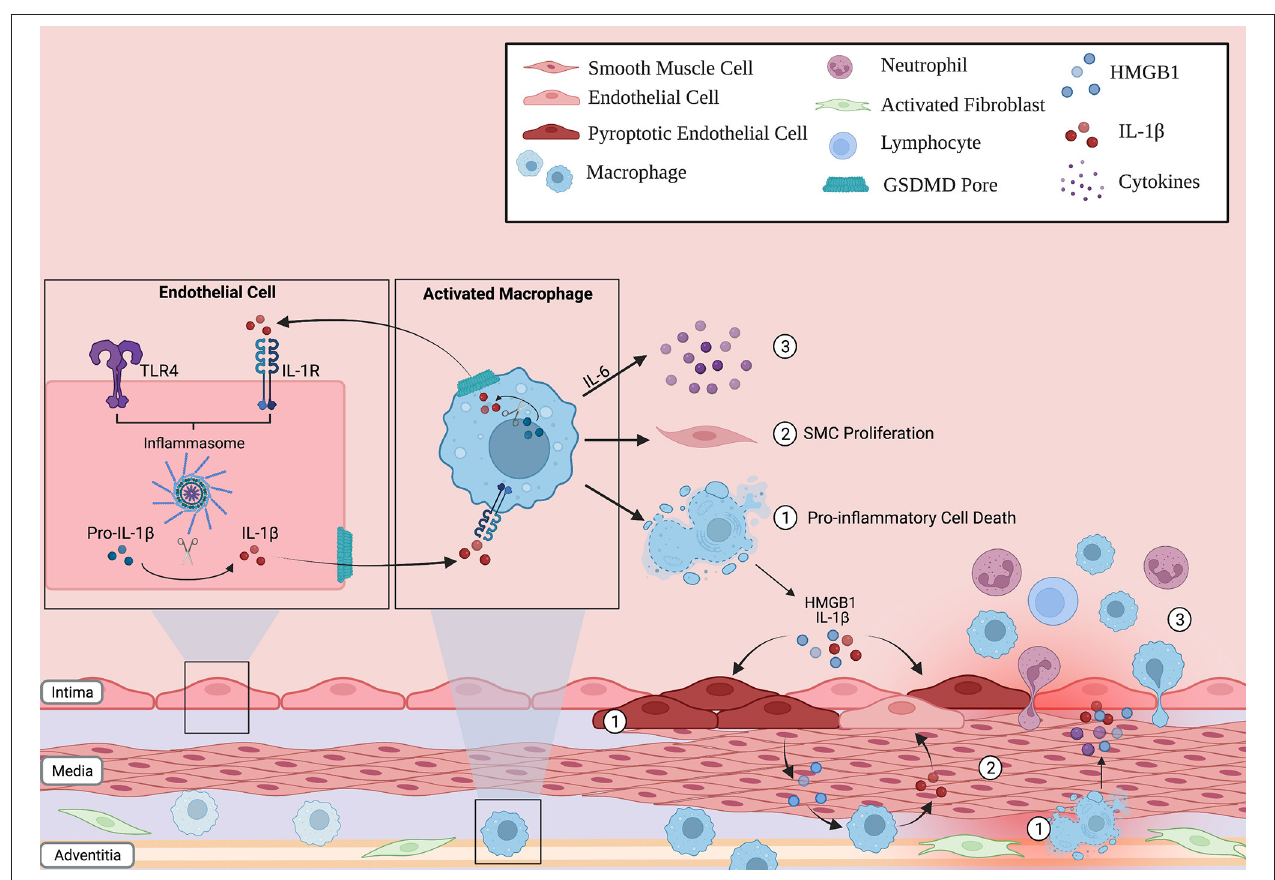
FIGURE 2 | Inflammasome action in the lung vascular environment. Immune cells (such as macrophages) and non-immune cells (endothelial cells) can respond to stress, activate the inflammasome pathway and undergo pyroptosis. The release of pro-inflammatory cytokines through the GSDMD pore, such as IL-1B, can propagate inflammation in neighboring cells by inducing their own transcription in a paracrine fashion. As such, the innate immune response can be amplified through the lung vasculature. In addition, these activated cells can (1) release other potent signaling molecules, such as HMGB1, into the environment following lytic cell death, (2) increase smooth muscle cell (SMC) proliferation in the medial layer of the vessel, and (3) release cytokines such as IL-6 that recruit other inflammatory cells to the vessel wall. Overall, this creates a vicious inflammatory cycle that, over time, contributes to the characteristic pulmonary vascular remodeling seen in PAH